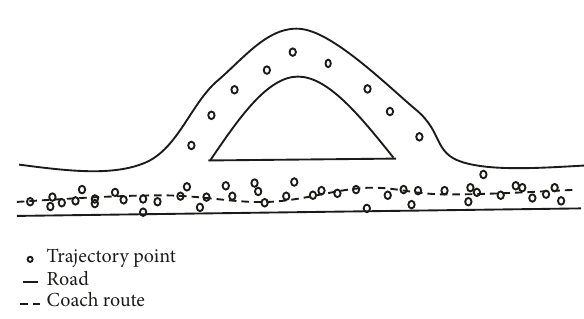
Figure 4: Coach route